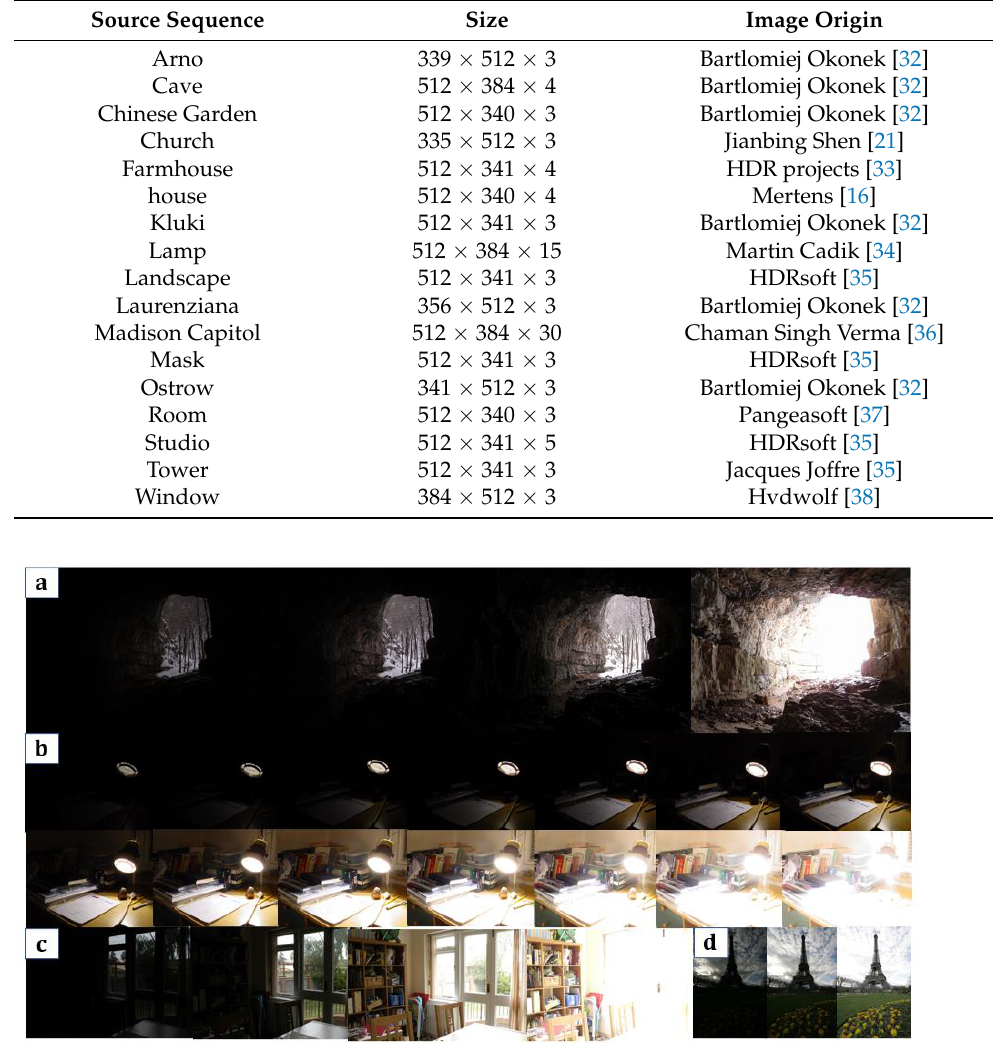
Figure 4. Four sets of multiple exposure image sequences. ( a ) ‘Cave’ image sequence. ( b ) ‘Lamp’ image sequence. ( c ) ‘House’ image sequence. ( d ) ‘Tower’ image sequence.